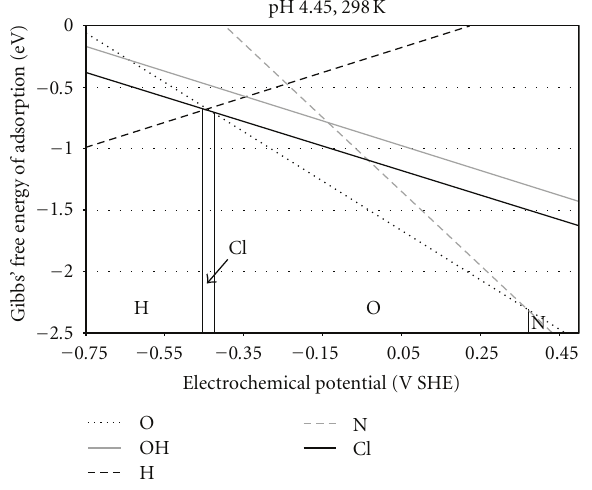
Figure 7: Free energy diagrams for surface coverage of the Fe(110) surface when exposed to a saturated NH 4 Cl solution at pH 4.45 and 25 ◦ C (298K). Reproduced with permission from